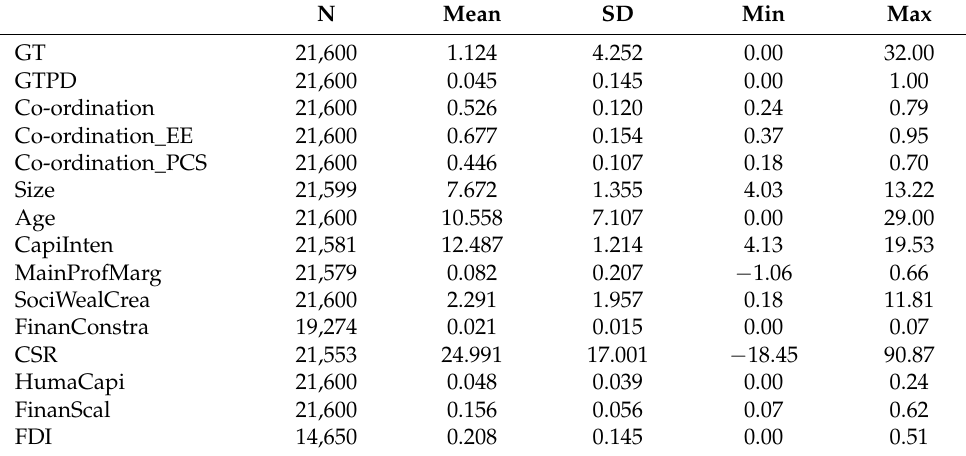
Table 2. Summary